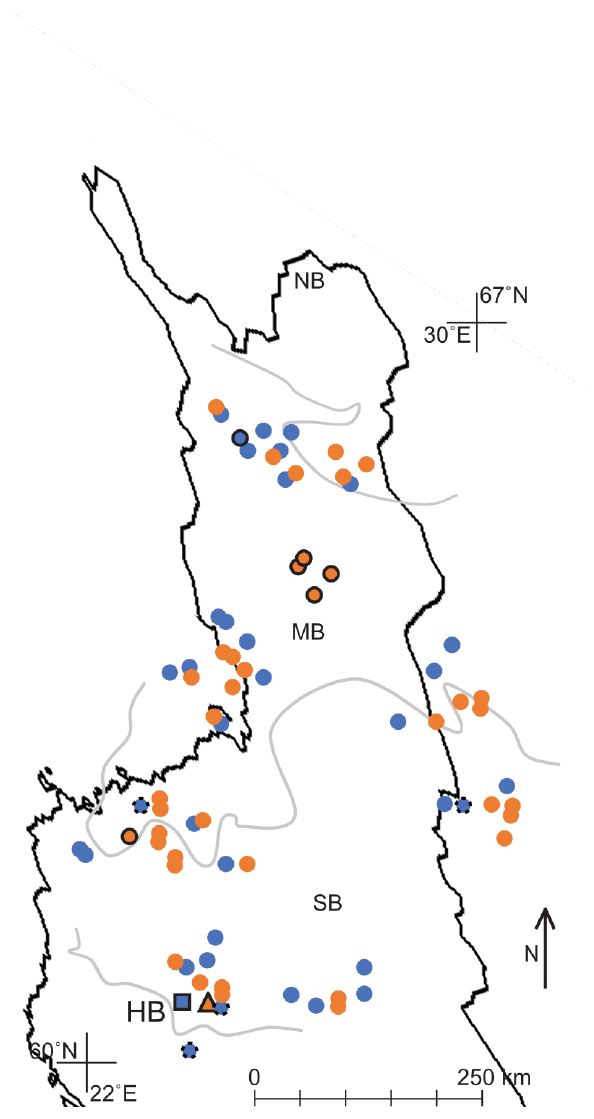
Figure 1. Study sites divided into nutrient rich (blue) and nutrient poor (orange) categories: Ojanen et al . (2013) (no border; those excluded from regression with dotted black border), Ojanen et al . 2019 (black border), Minkkinen et al . (2018) (triangle with black border), Korkiakoski et al . (2018) (square with black border). Grey lines denote the boundaries of vegetation zones (Ahti et al . 1968): HB, hemiboreal; SB, south boreal; MB, middle boreal; NB, north boreal. (Ojanen et al. 2013, n = 68; and control plots of a fertilisation study by Ojanen et al . 2019, n = 6), NE is estimated from heterotrophic soil CO2soil respiration (R ) and total litter production (L): het NE = R – CO2soil het